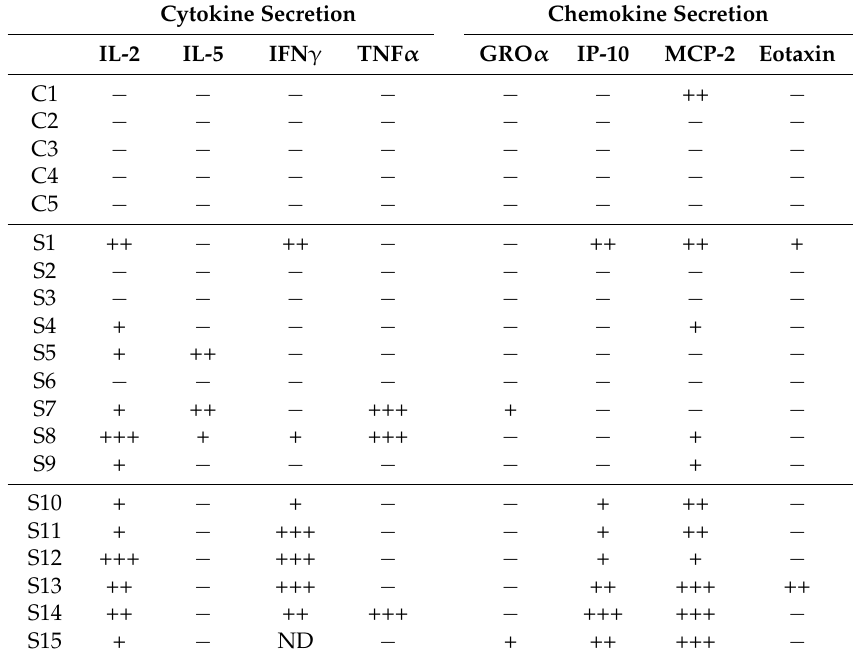
Table 3. Summary of cytokines and chemokines secretion levels by multiplex ELISA following SUDV whole antigen stimulation in SUDV survivors and non-infected